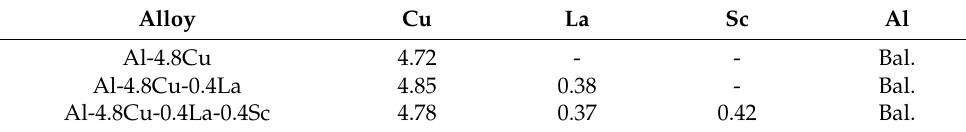
Table 1. Chemical composition of the present Al-Cu, Al-Cu-La, Al-Cu-La-Sc (wt.%). Alloy Cu La Sc Al